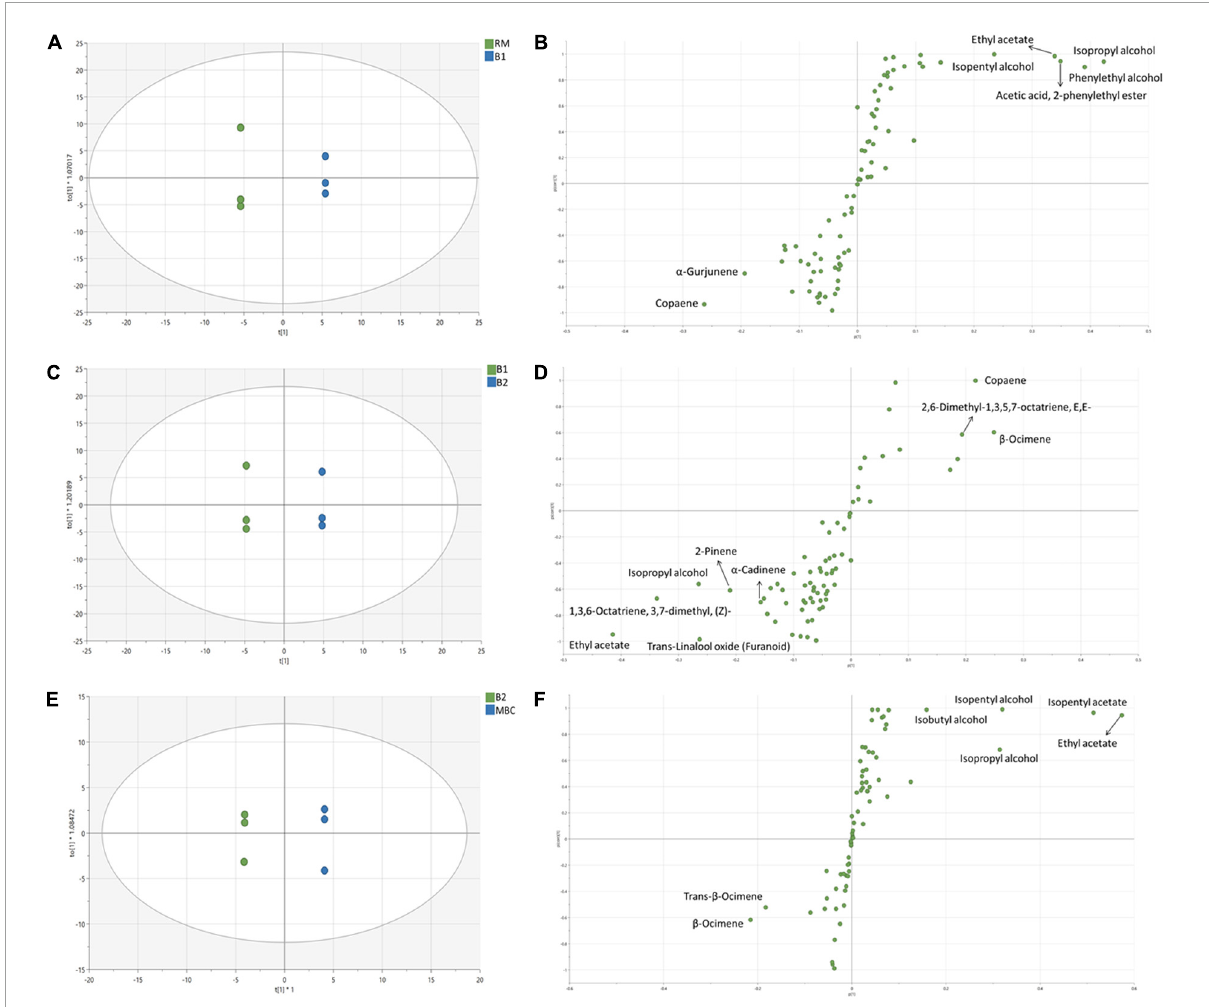
FIGURE3 OPLS-DA score plot and S-plot of volatile metabolites of S1 (A,B) , S2 (C,D) , and S3 (E,F) . Each dot in the score plot represents a biological